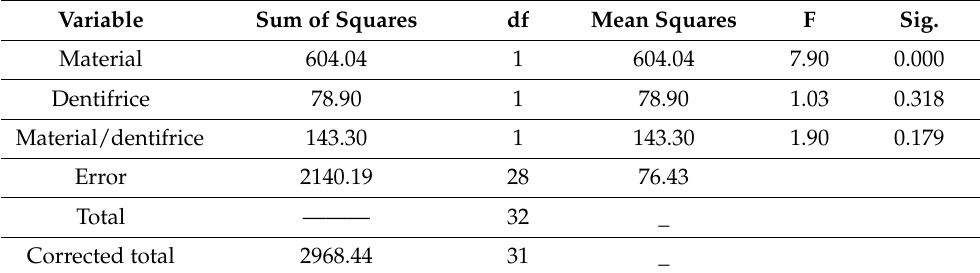
Table 9. Influence of material and dentifrice on gloss using two-way ANOVA.